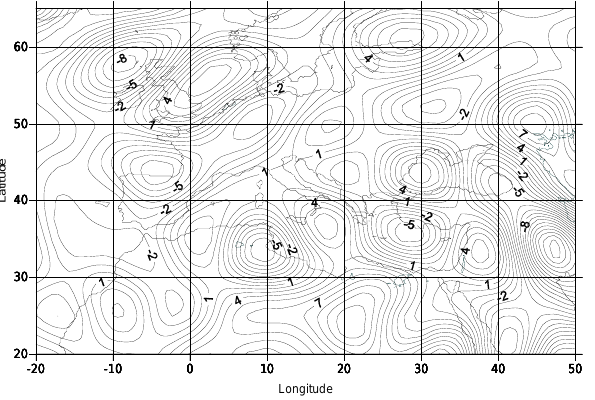
Fig. 7. The divergence of the horizontal wind vector over the